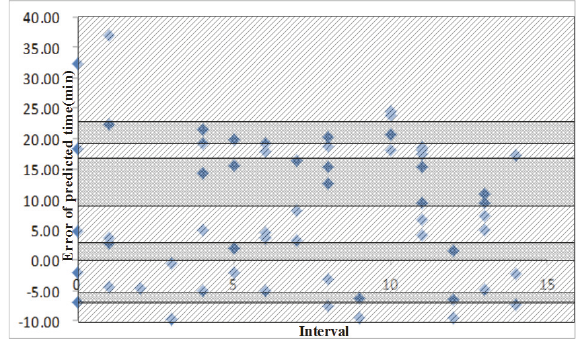
Figure 5: Prediction error distribution of 𝐿 1,1 .